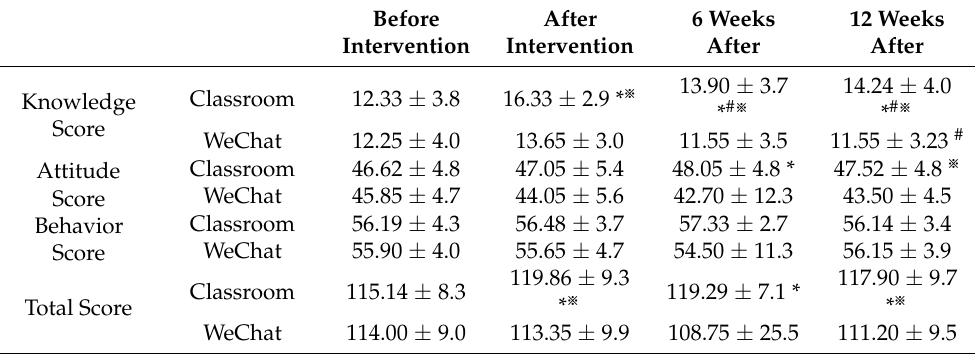
Table 5. Score changes of athlete nutrition KAP questionnaire (N =